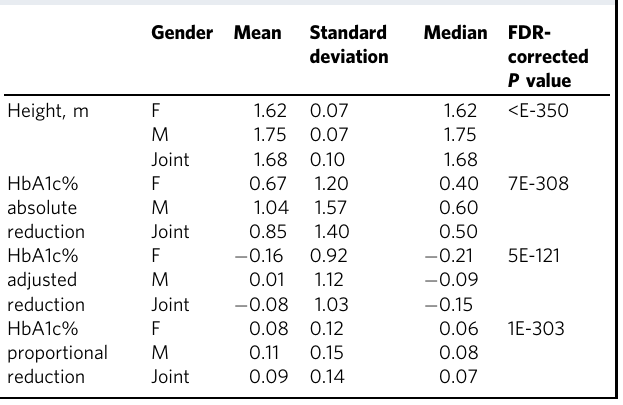
Table 3 Cohort Phenotypes Statistics.